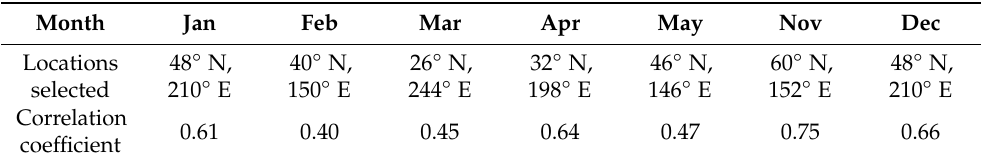
Table 4. Selected locations from the global climate data for the extended reconstructed sea surface temperature